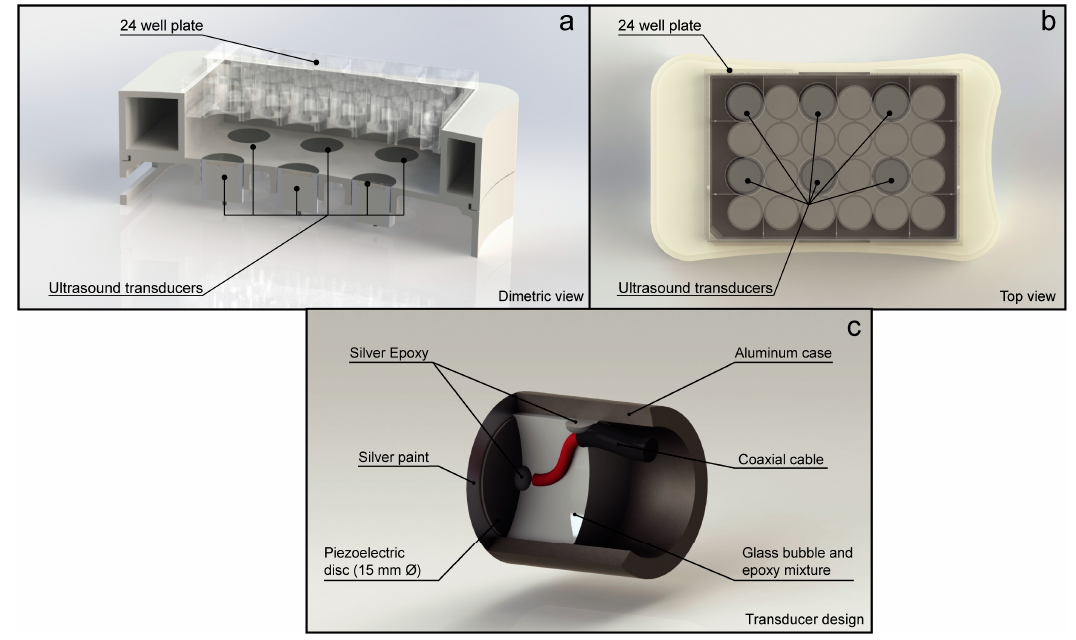
Figure 1. Ultrasound treatment chamber and transducer design used to treat the cells. ( a ) Cutaway of the dimetric view of ultrasound treatment chamber showing the distance. ( b ) Top view of the chamber showing which cell culture wells were exposed to ultrasound. ( c ) Cutaway of the transducer design used in the ultrasound treatment chamber. Table 1. Ultrasound conditions used to treat the cells.